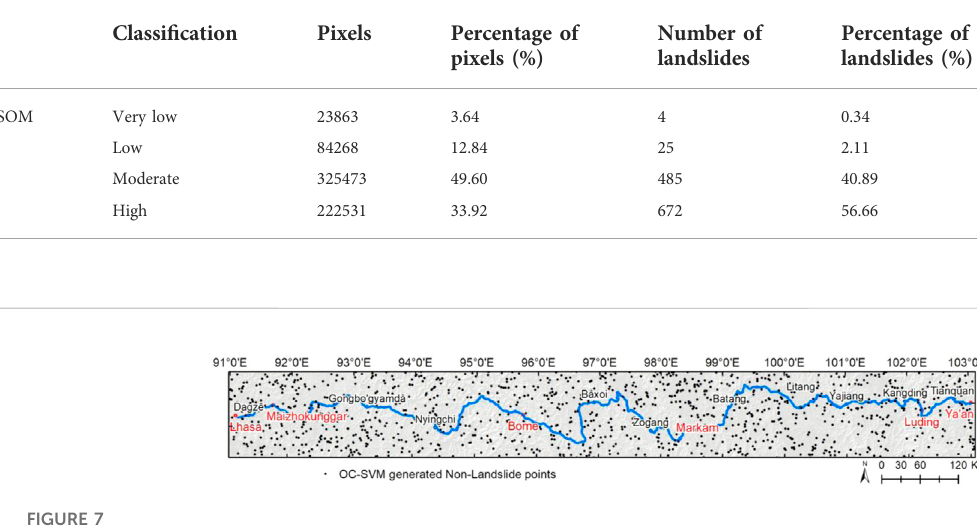
FIGURE 7 OC-SVM generated distribution map of non-landslide samples.